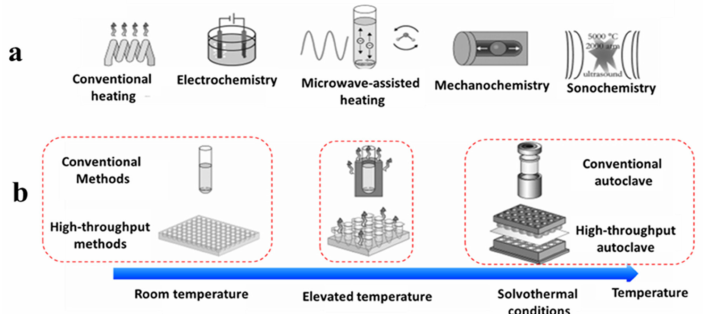
Figure 2. Illustration of various reported MOF fabrication techniques in the literature; conventional hydrothermal and microwave-assisted hydrothermal approaches are the most commonly applied approaches, while electrochemical, mechanochemistry, and ultrasound-assisted methods are quite new techniques in the synthesis of MOFs ( a ) [7]. A wide range of temperatures from room conditions to solvothermal conditions are applied in the fabrication of MOFs ( b )